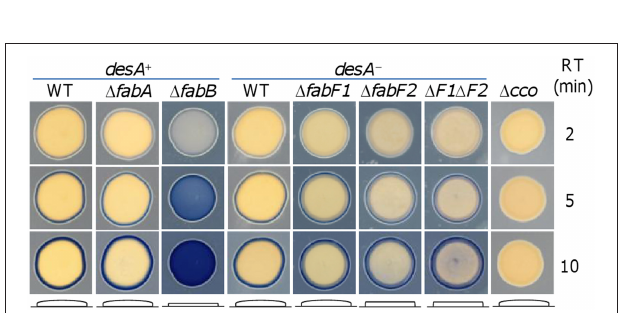
FIGURE 4 | Effects of fabA , fabB , fabF1 , and fabF2 mutations on morphology. Morphology of cell patches grown from a drop of mid-log phase culture for each strain on LB plates was assessed by Nadi assay as described in Methods. The blue ring formed by Nadi assay manifests the activity of cytochrome c oxidase, which is missing in the negative control 1 cco . Morphology of cell patches for each strain is illustrated by respective diagram given at the bottom. Nadi reagents could penetrate through the boundary of cell patches that are too thin as seen with 1 fabB , 1 fabF2 , and 1 fabF1 1 fabF2 . Three reaction times (RT) were presented to show the progress of the Nadi reaction. 1 F1 1 F2 represents 1 fabF1 1 fabF2 . The diameters of the patches were 8 ± 1mm. Presented are representative results of three independent